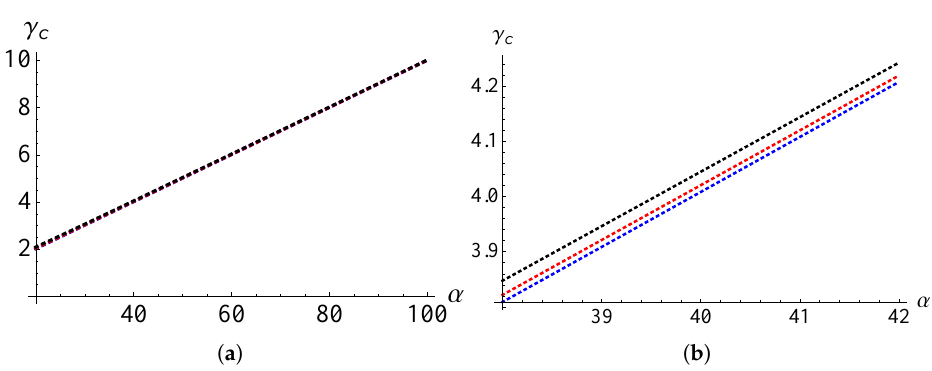
Figure 1. The critical velocity versus nonlocal parameter α when p = 0.04, k s = 0.004 and ξ 1 = 0.5. Black dotted line, red dotted line and blue dotted line denote the results for k = 3,2,1 mode, respectively. ( a ) full graph, ( b ) enlarger partial of full graph.